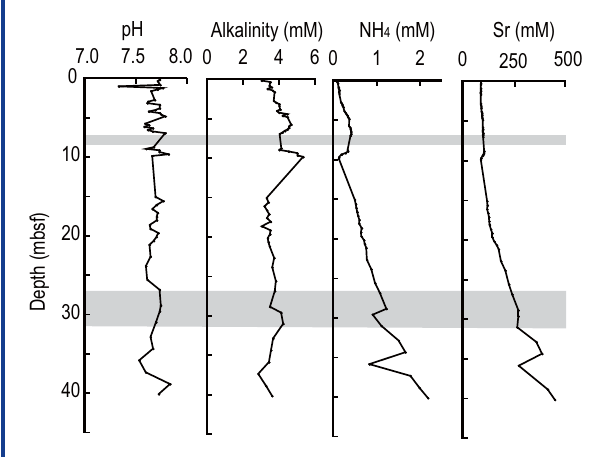
Figure 11. Porewater geochemistry data from Hole M0058A. Gray bars represent the two coarse sand/grainstone units